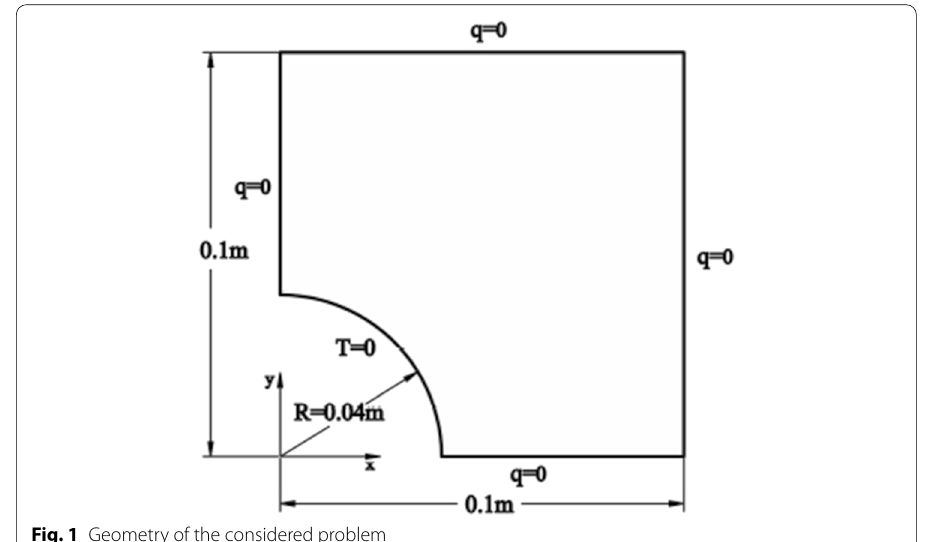
Fig. 1 Geometry of the considered